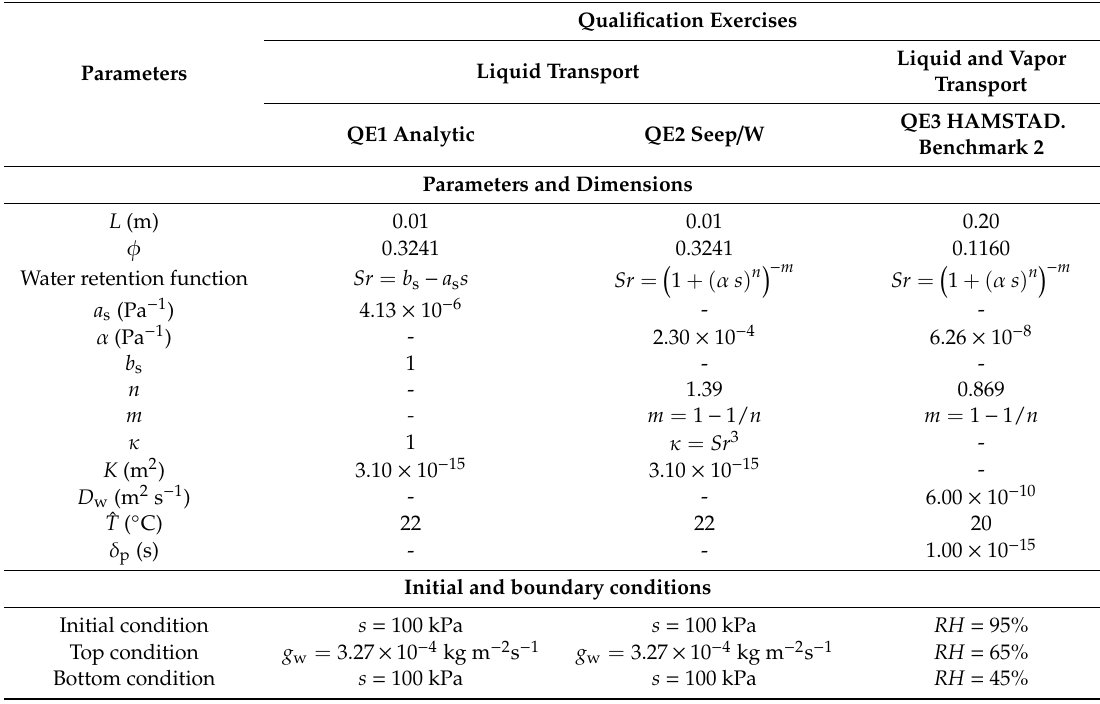
Table 1. Parameters and dimensions of the simulated material